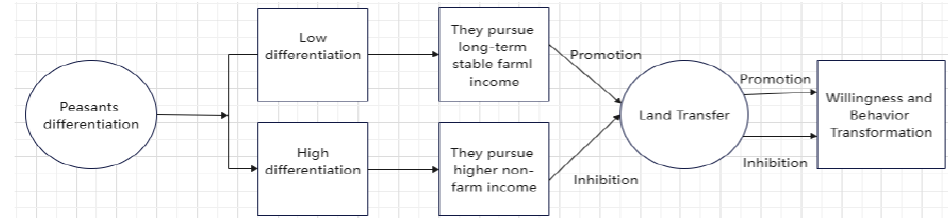
Figure 1. The impact of peasant differentiation on the transformation of willingness and behavior of land